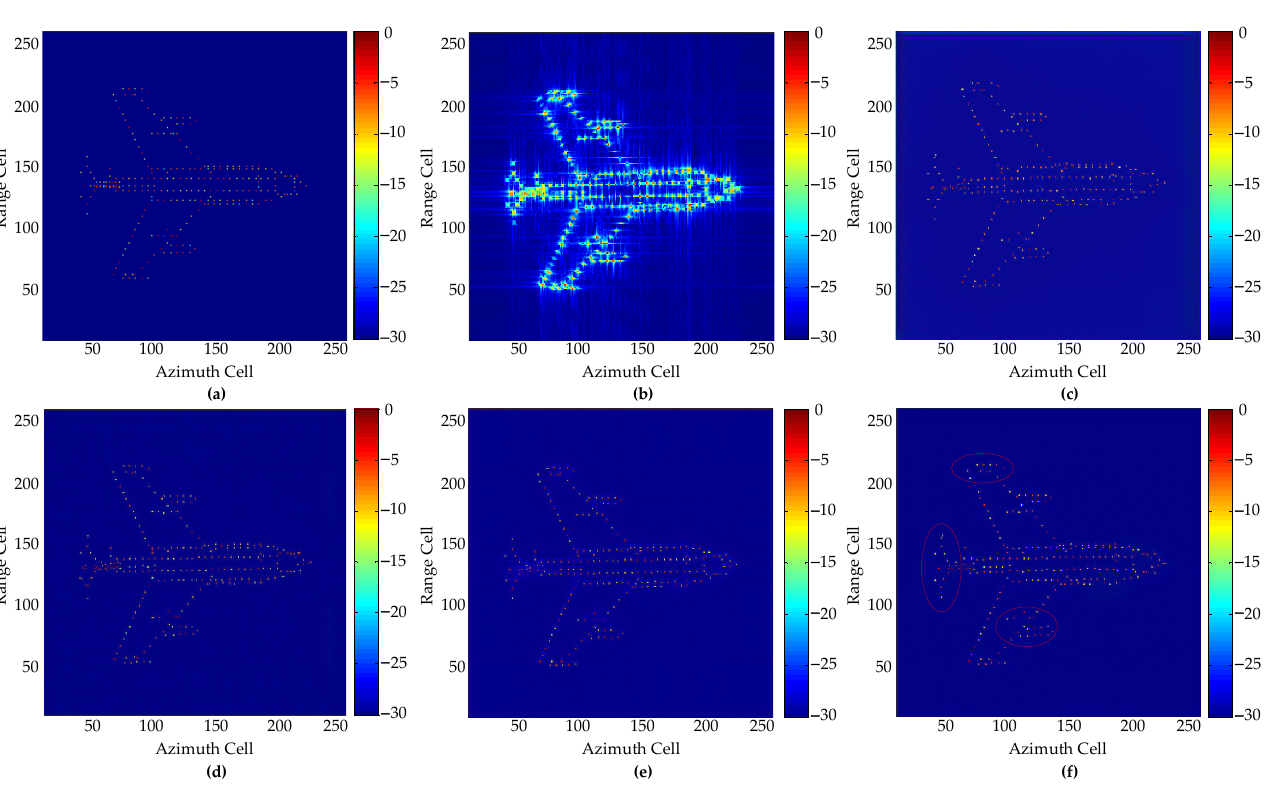
Figure 5. Imaging results of simulated aircraft under the condition of no noise and full aperture: ( a ) Ground truth; ( b ) IFFT; ( c ) GAN1; ( d ) GAN2; ( e ) GAN3; ( f ) Proposed GAN. Table 1. Numerical performance evaluation for simulated aircraft under ideal environment.